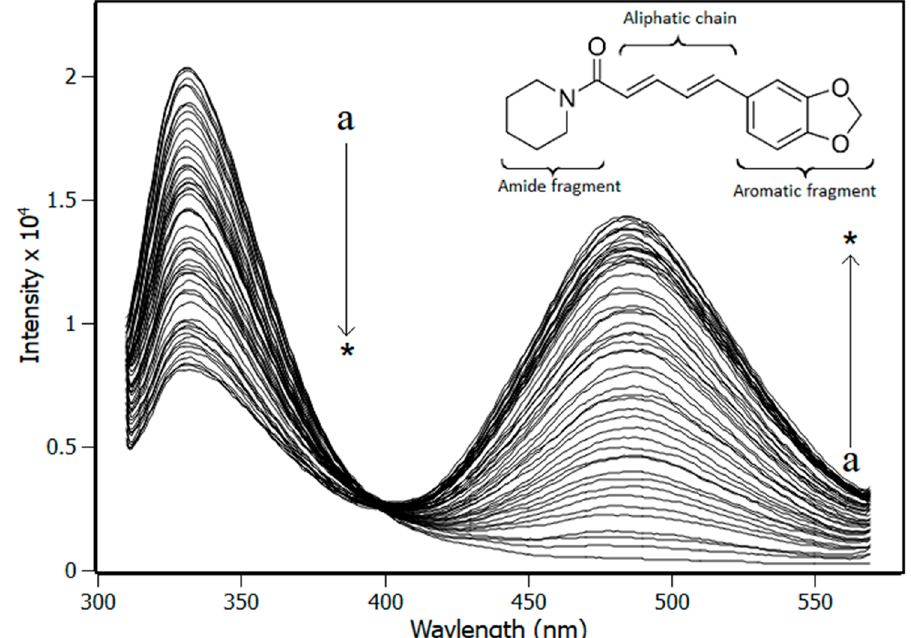
Figure 1. Spectra of fluorescence emission of nucleotide binding domain (NBD) obtained from titration experiments with increments in the concentration of piperine (pH 7.4, T = 288 K, λ exc = 295 nm). (NBD) = 4.0 μ M; piperine titrations with increment of 0.5 μ M (a → * = 0 μ M → 20 μ M).